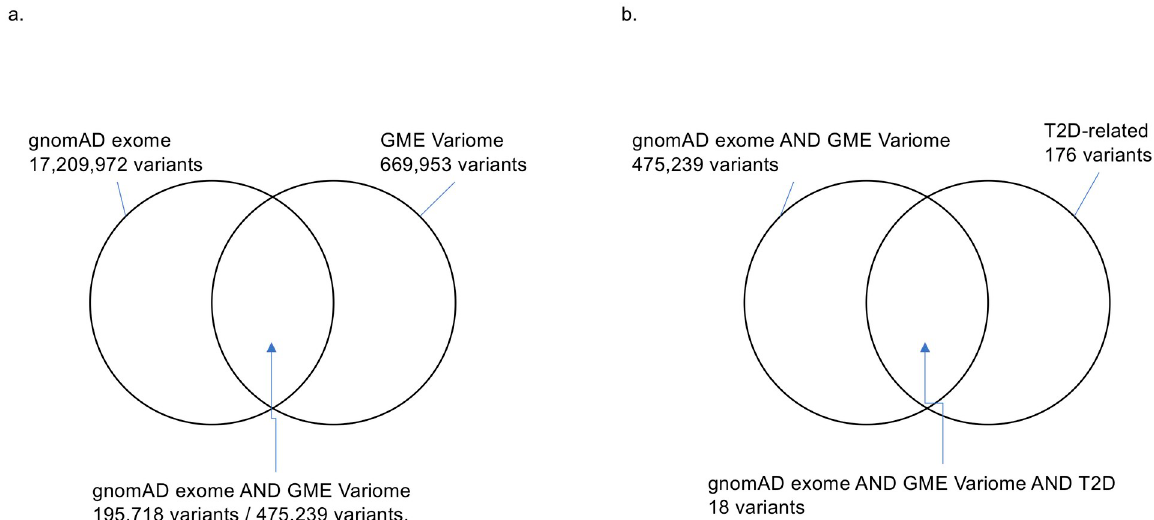
Fig 1. Number of variants. (a) The intersection between the gnomAD exome and GME Variome data. 475,239 variants commonly exist in two databases. After the eliminating rare variants, 195,718 variants remained. (b) Intersection among the gnomAD exome, GME Variome, and T2D- related